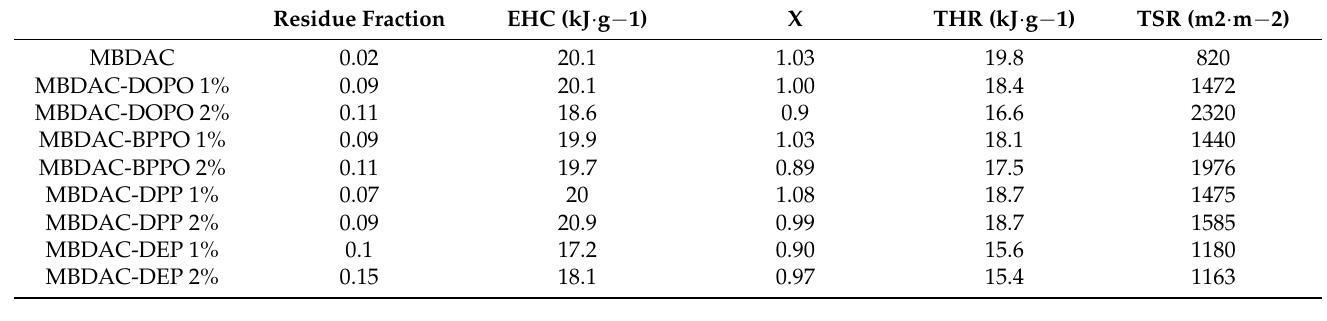
Table 5. Main data from cone calorimeter tests for all PHUs.